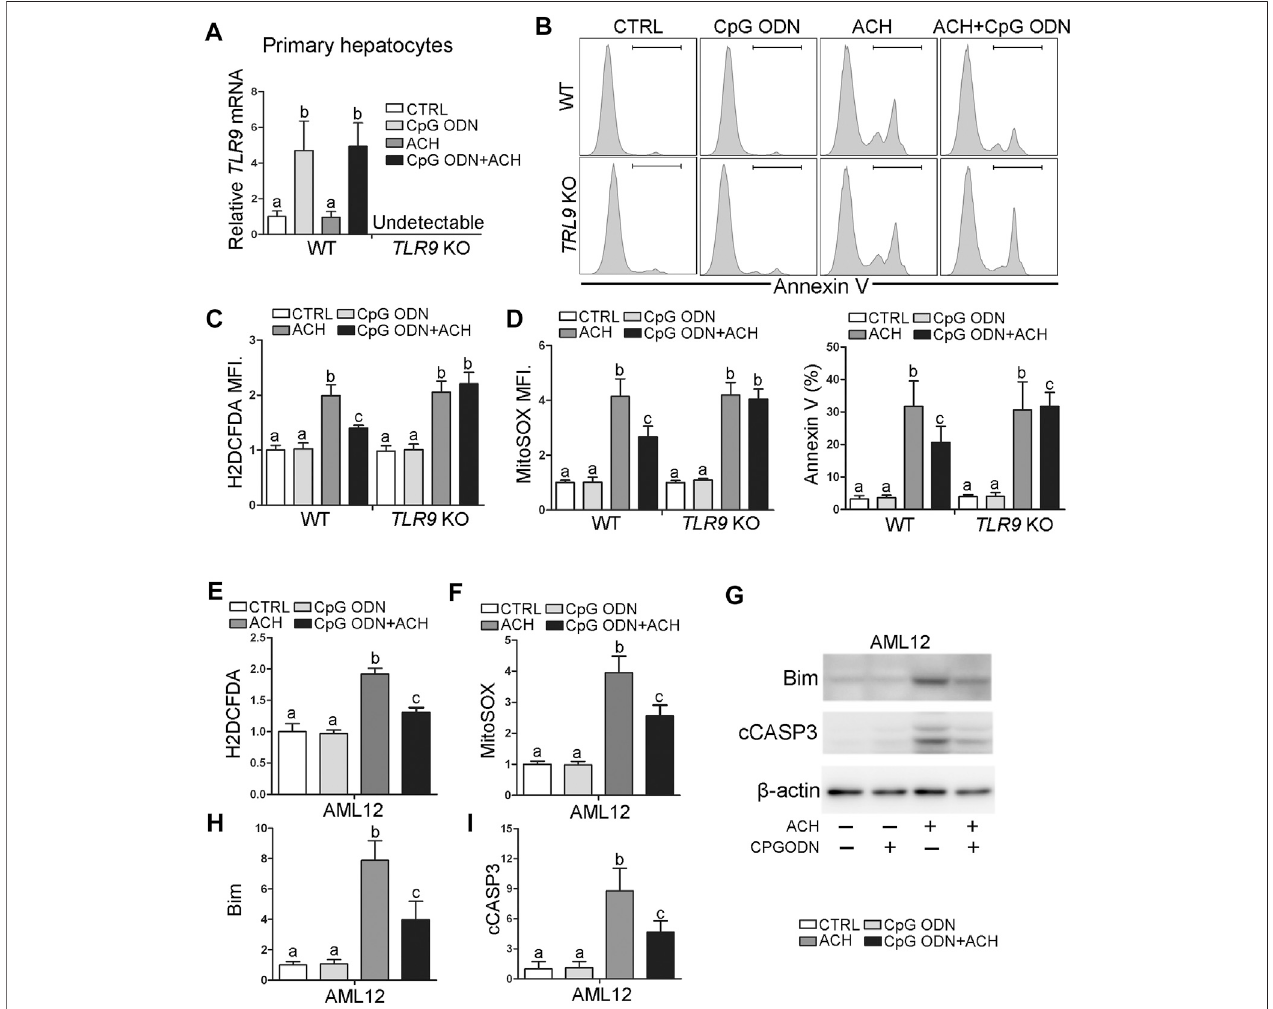
FIGURE 4 | TLR9 activation ameliorates acetaldehyde-induced oxidative stress, mitochondrial dysfunction, and apoptosis in hepatocytes. (A – D) Primary hepatocytesisolatedfromwild-typeandTLR9KOmiceweretreatedwithCpGODNandacetaldehyde(ACH). (A) Relative TLR9 mRNAlevelsinprimaryhepatocytes. (B) FACS analysisofapoptotic celldeathrepresentedbyAnnexinVpositivecells. (C) FACS analysisofhepatic total ROSusing H2DCFDA dye.Dataarethesummaryofthe mean fl uorescence intensity (MFI). (D) FACS analysis of hepatic mitochondrial ROS using MitoSOX dye. Data are the summary of the mean fl uorescence intensity (MFI). (E – I) AML12 cells were treated with CpG ODN and ACH. (E) FACS analysis of hepatic total ROS using H2DCFDA dye. Data are the summary of the mean fl uorescence intensity (MFI). (F) FACS analysis of hepatic mitochondrial ROS using MitoSOX dye. Data are the summary of the mean fl uorescence intensity (MFI). (G) WesternblottingofBimandcCASP3. (H – I) BargraphsofBimandcCASP3.Proteinbandsintensitywasquanti fi edbyImageJ(NIH).Dataarepresentedasmeans ± SD. Statistical comparisons were made using one-way ANOVA with Tukey ’ s post hoc test. Bars with different characters differ signi fi cantly ( p < 0.05).